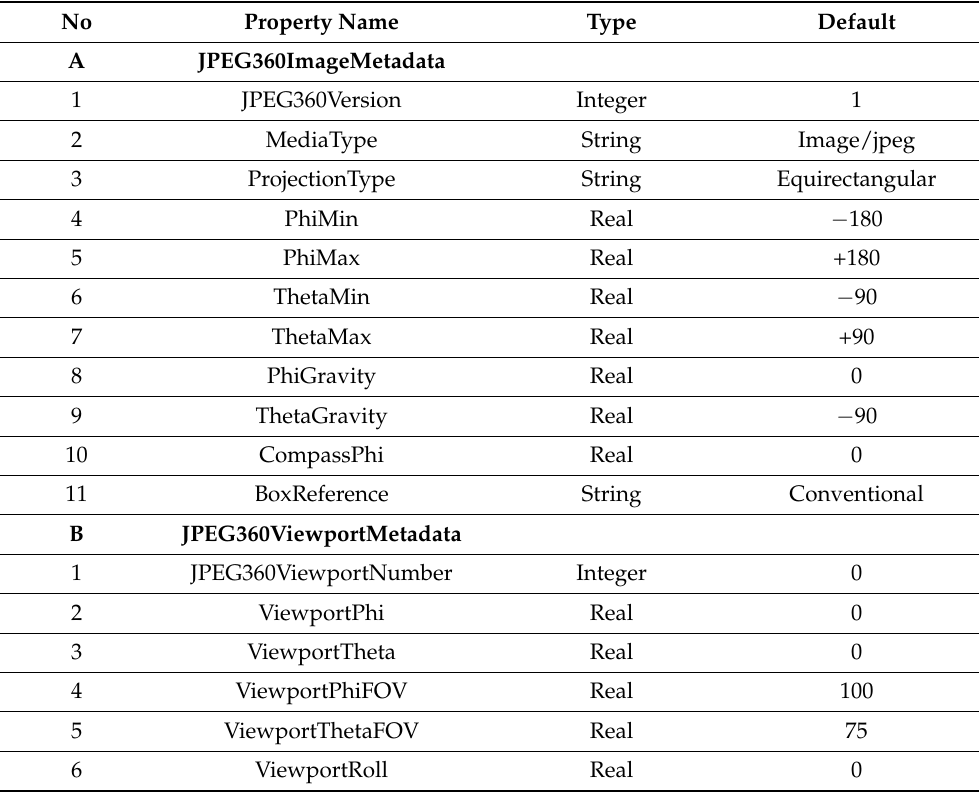
Table 5. JPEG 360 metadata